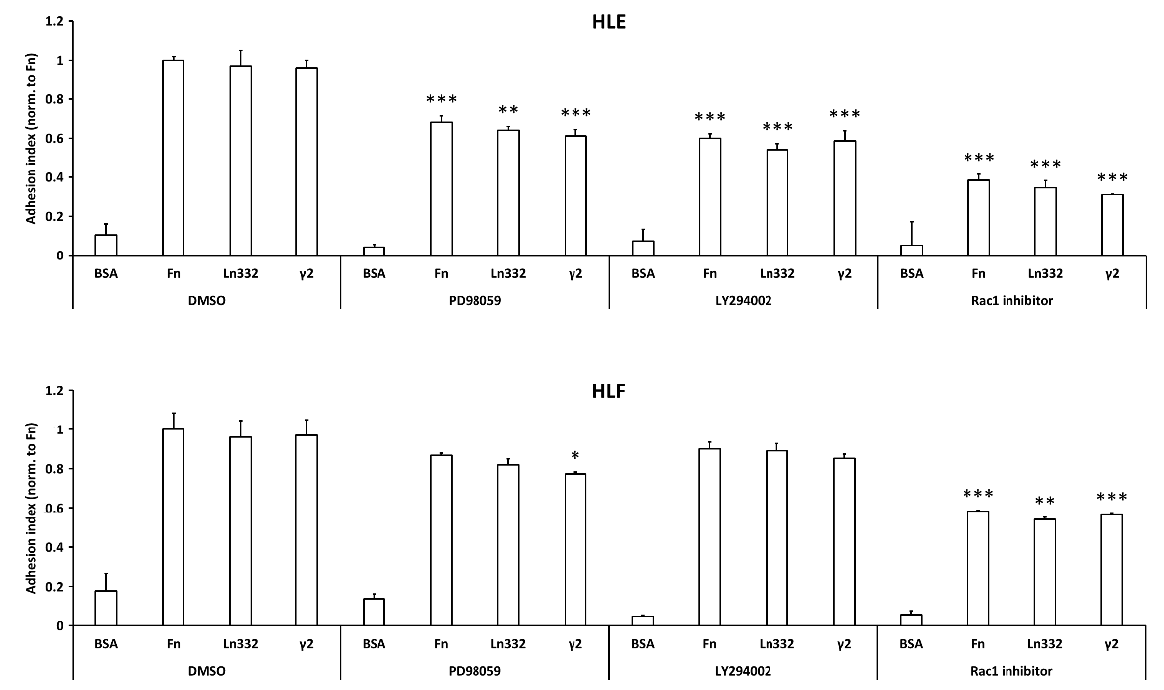
Figure 3. Adhesion of HCC cells to γ2 chain of Ln332 depends in part on the activation of Rac1. HLE and HLF were pre-incubated with vehicle (DMSO, dilution 1:286 vol/vol), ERK1/2 inhibitor (PD98059, 50 µM), AKT inhibitor (LY294002, 25 µM), or active Rac1 inhibitor (CAS 117786517-6, 50 µM), for 2 h at 37 °C; then, the cells were seeded on uncoated, or fibronectin (Fn), or laminin-332 (Ln332), or γ2 -coated well surfaces and allowed to attach and spread for 30 minutes. Data are the means ± SD of triplicates, T test (unpaired, two-tailed): * p < 0.05, ** p < 0.01, and *** p < 0.001, vs. corresponding ECM protein in control (DMSO).